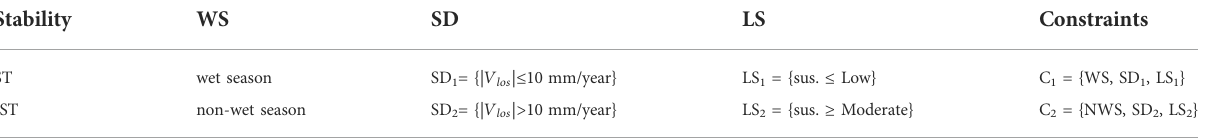
TABLE 1 Constraints on the construction of the joint response mechanism.